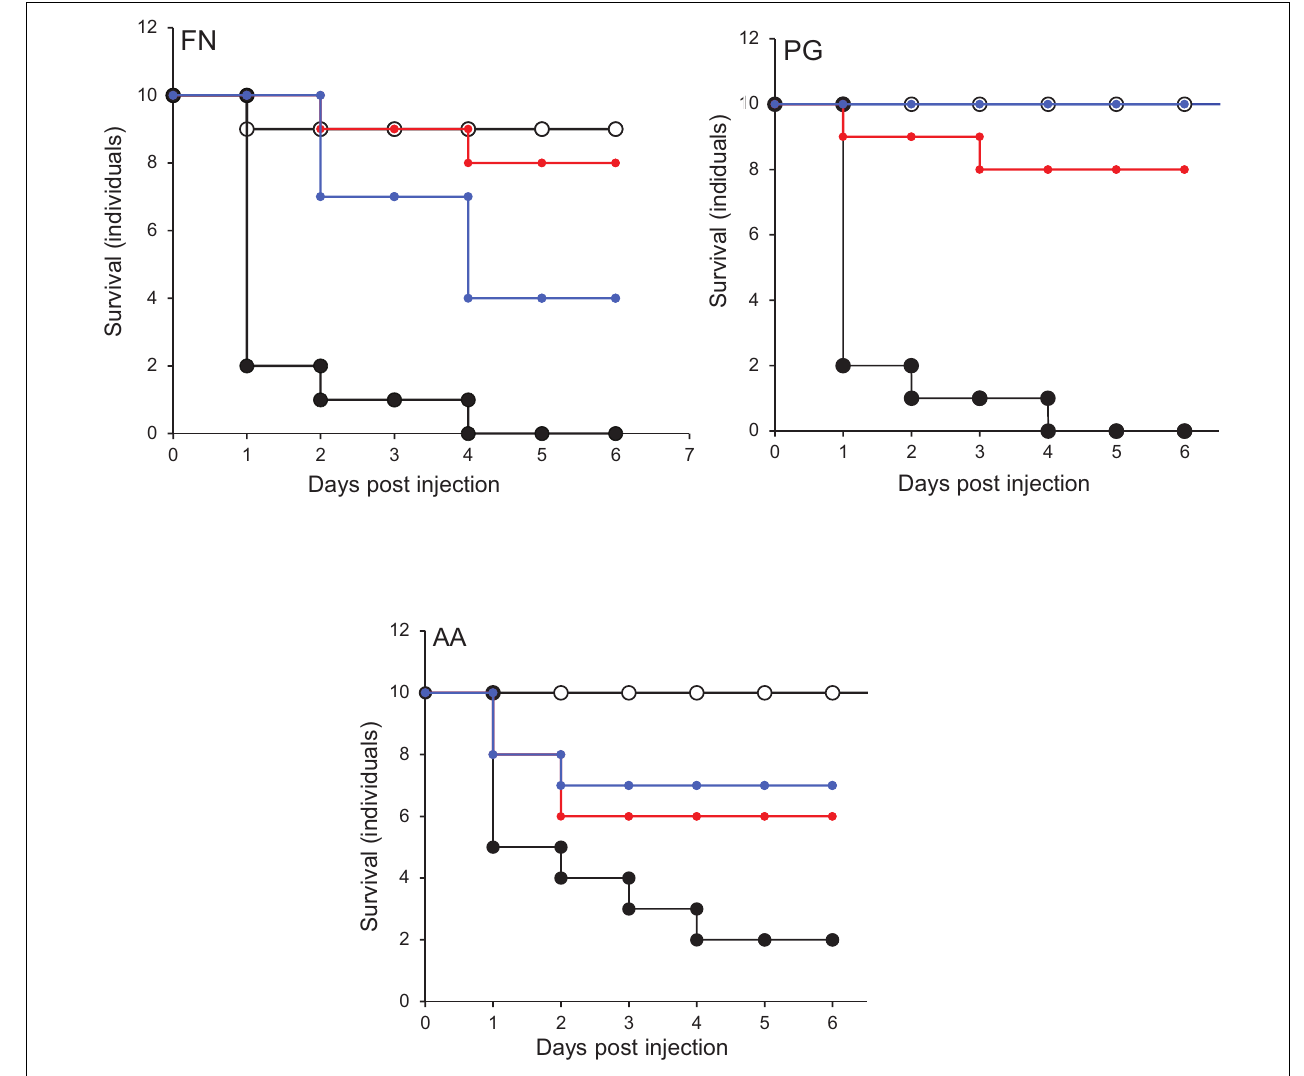
FIGURE 4 | The lethal effect of periodontal pathogens in an invertebrate model. Kaplan-Meier plots of survival of G. mellonella larvae after challenge with periodontal pathogens. F. nucleatum (FN), Porphyromonas gingivalis (PG), or A. actinomycetemcomitans (AA). Viable bacterial suspension (black symbols), cell-free culture supernatant (blue symbols), bacterial lysate (red symbols), and PBS (white symbols). All experiments were done twice on 2 consecutive weeks, with different batches of larvae and with three replica plates where each plate contains 10 larvae. All three periodontal pathogens caused at least 50% larvae morality at the endpoint of the experiment. The mortality effects of F. nucleatum and P. gingivalis were significantly greater than A. actinomycetemcomitans ( p < 0.05) in the order F. nucleatum > P. gingivalis > A . actinomycetemcomitans . Bacterial lysates and cell-free culture supernatants contributed to the reduction of larvae viability, but the lethal effects were lower than for viable